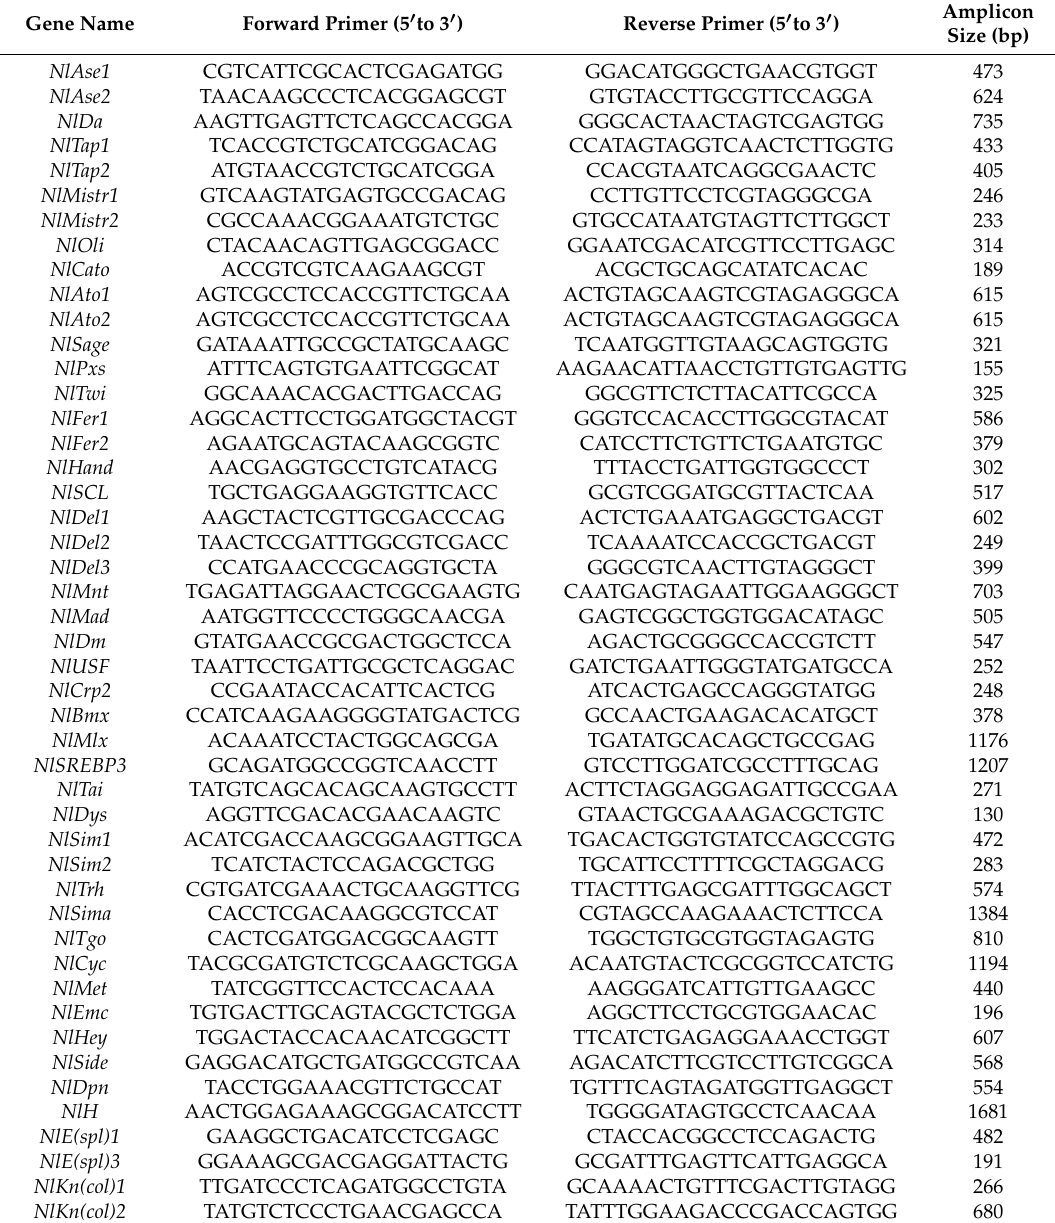
Table 1. The primers used in reverse transcription polymerase chain reaction (RT-PCR) for Nilaparvata lugens basic helix-loop-helix ( NlbHLHs)